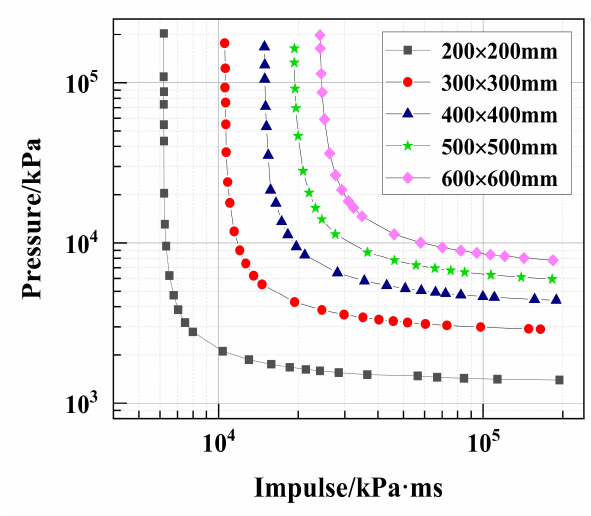
Figure 15. P-I curves of bending response with a different cross-sectional dimension.